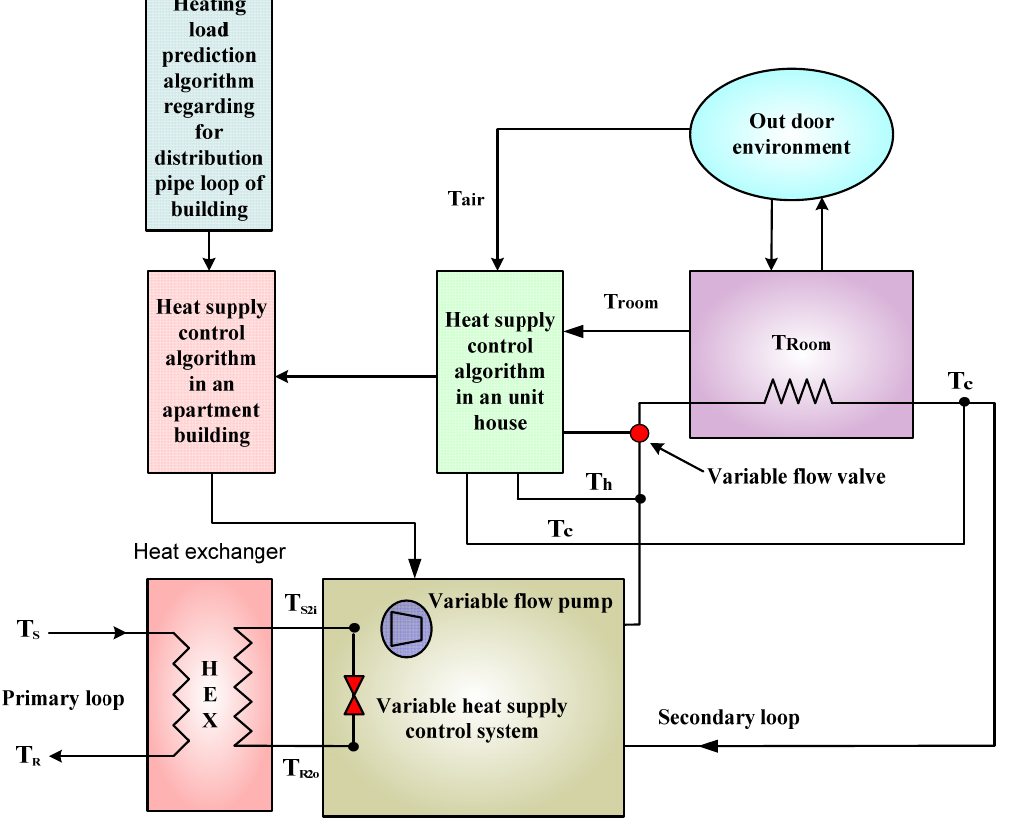
Figure 8. Schematic diagram of optimal heat supply control algorithm that varies the supply water temperature and mass flow rate according to outdoor air